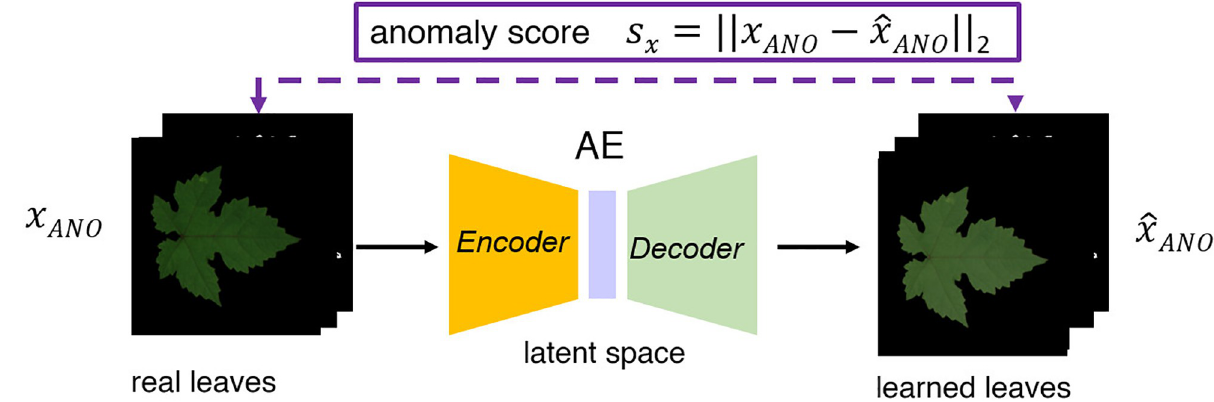
Fig 9. AE for anomaly detection. The AE is trained with images of real leaves to be the identity operator of the input. A synthetic leaf with a low level of similarity is recognized as an anomaly if fed into the trained AE and its anomaly score s x is high.